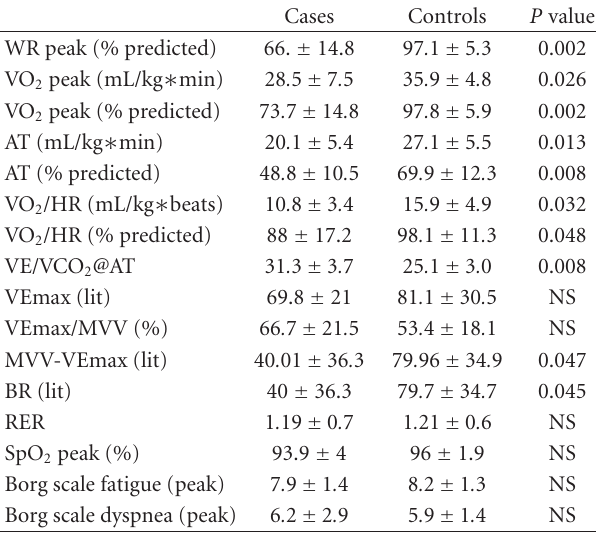
Table 2: Exercise parameters in cases and